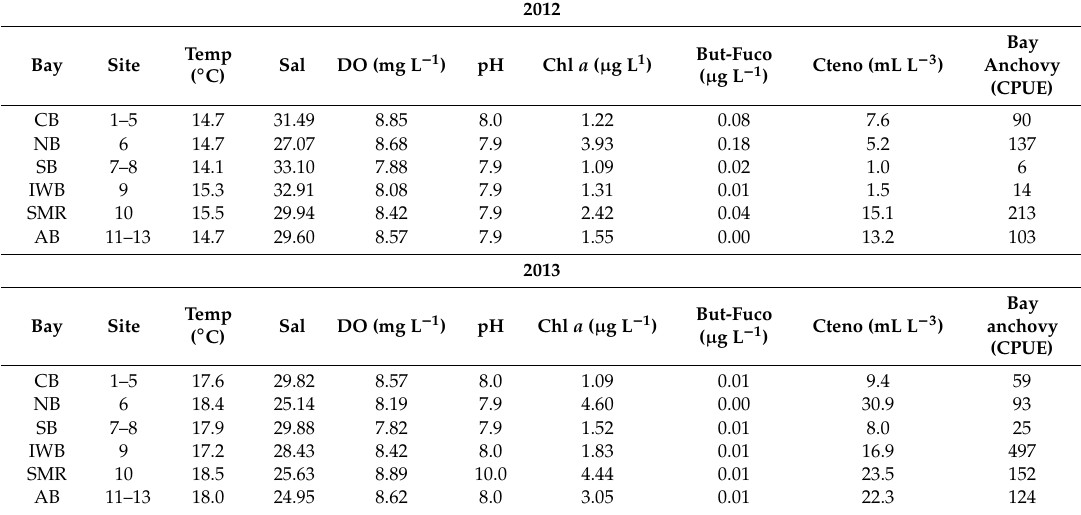
Table 1. Mean physico-chemical and biotic factors measured at sampling stations within embayments of the Maryland Coastal Bays. Embayment codes are: CB, Chincoteague Bay; NB, Newport Bay; SB, SinepuxentBay; IWB,IsleofWightBay; SMR,St. MartinRiver; AB,AssawomanBay. Temp,